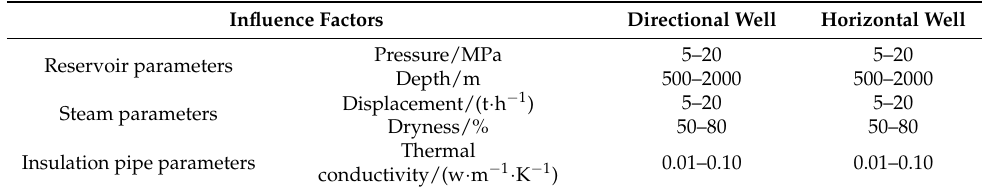
Table 1. Simulation scheme of influencing factors of critical nitrogen injection